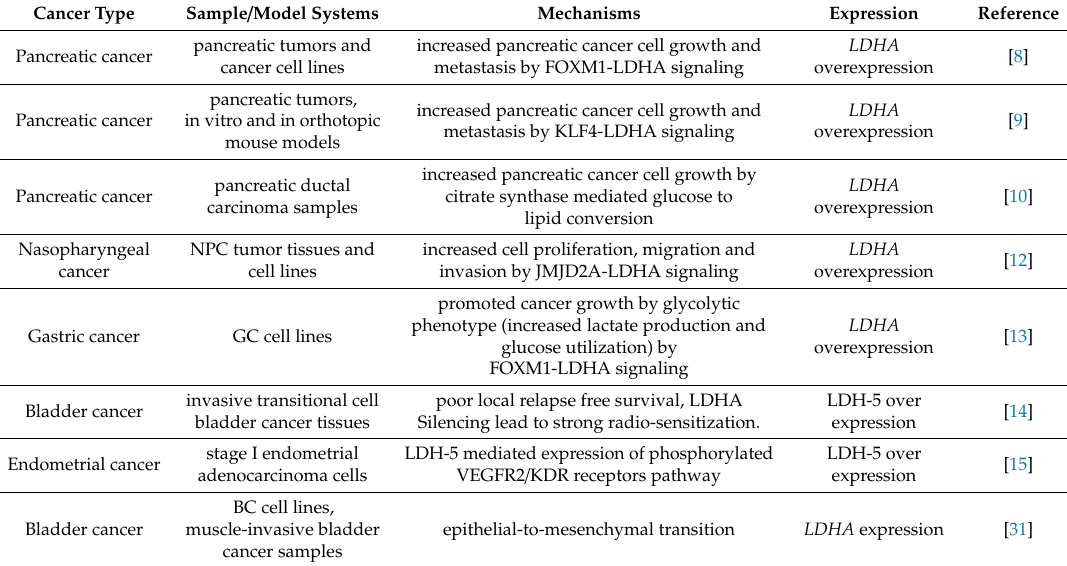
Table 1. LDHA -mediated cancer